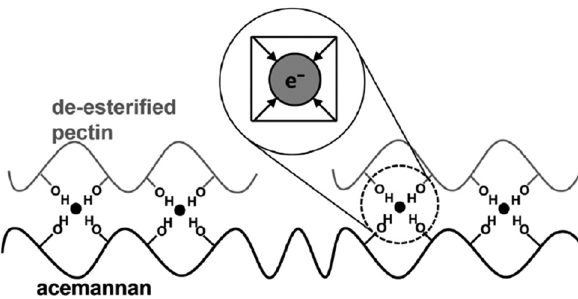
Figure 12: Possible electron trapping mechanism of the Aloe vera - based RRAM shown in a conceptual drawing with two main com - pounds in Aloe vera, namely acemannan and pectin, having – OH groups acting as trap sites for electrons ( • ) . The four arrows pointing to an electron indicate the positive partial charge of a permanent dipole of – OH [ 87 ] . Reproduced by permission of